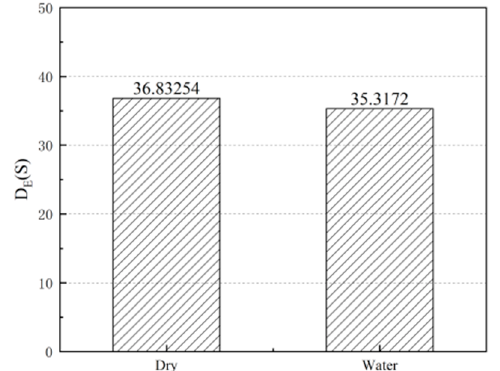
Figure 9. D E of CR mixture before and after immersion under medium temperature fatigue failure.